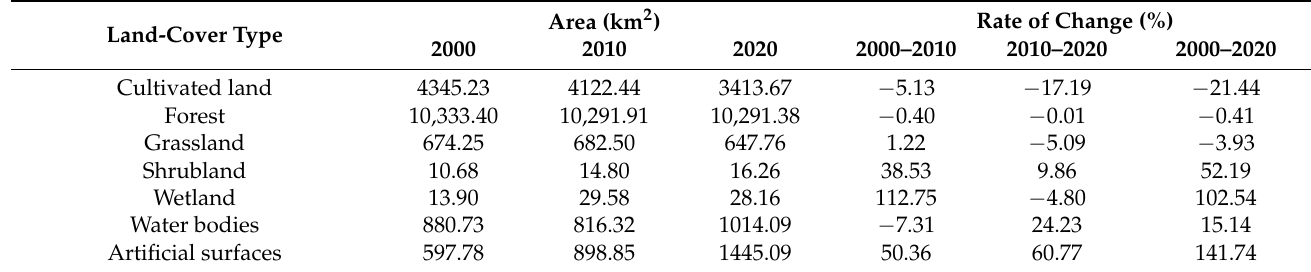
Figure 3. Spatial distribution of land cover in Hangzhou from 2000 to 2020. Table 7. Area changes in each land-cover type in Hangzhou from 2000 to